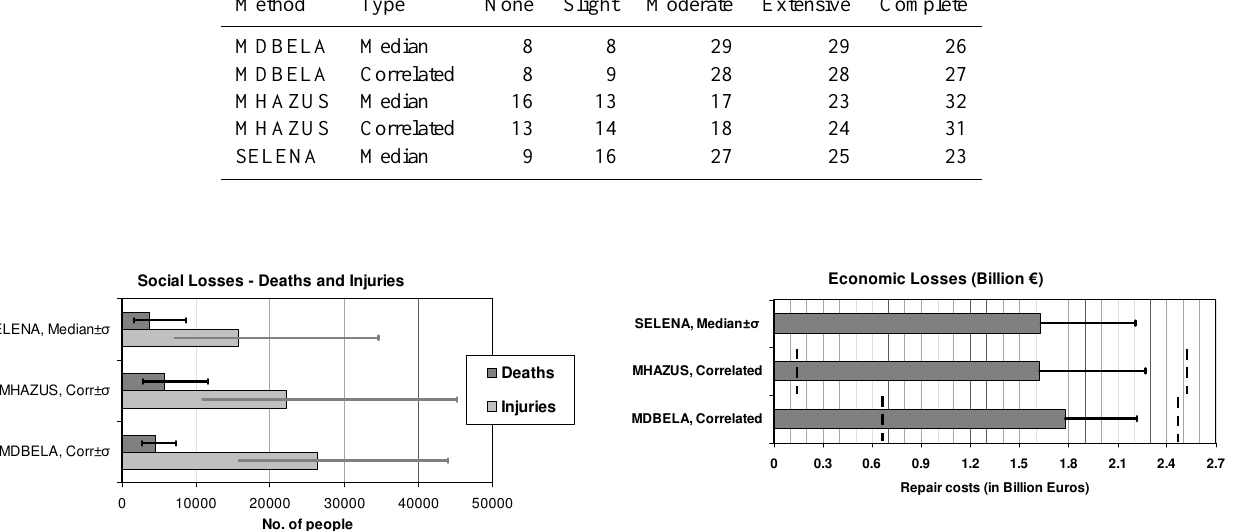
Figure 10. Daytime economic losses for the 3 ELE software packages including the 2 Fig. 10. Daytime economic losses for the 3 ELE software packages minimum, maximum and 84%(+1 σ ) values from the 100 runs. SELENA was only run using 3 including the minimum, maximum, and 84%(+1 σ) values from the 100 runs. SELENA was only run using the available median and the available median and 84% values. 4 84%